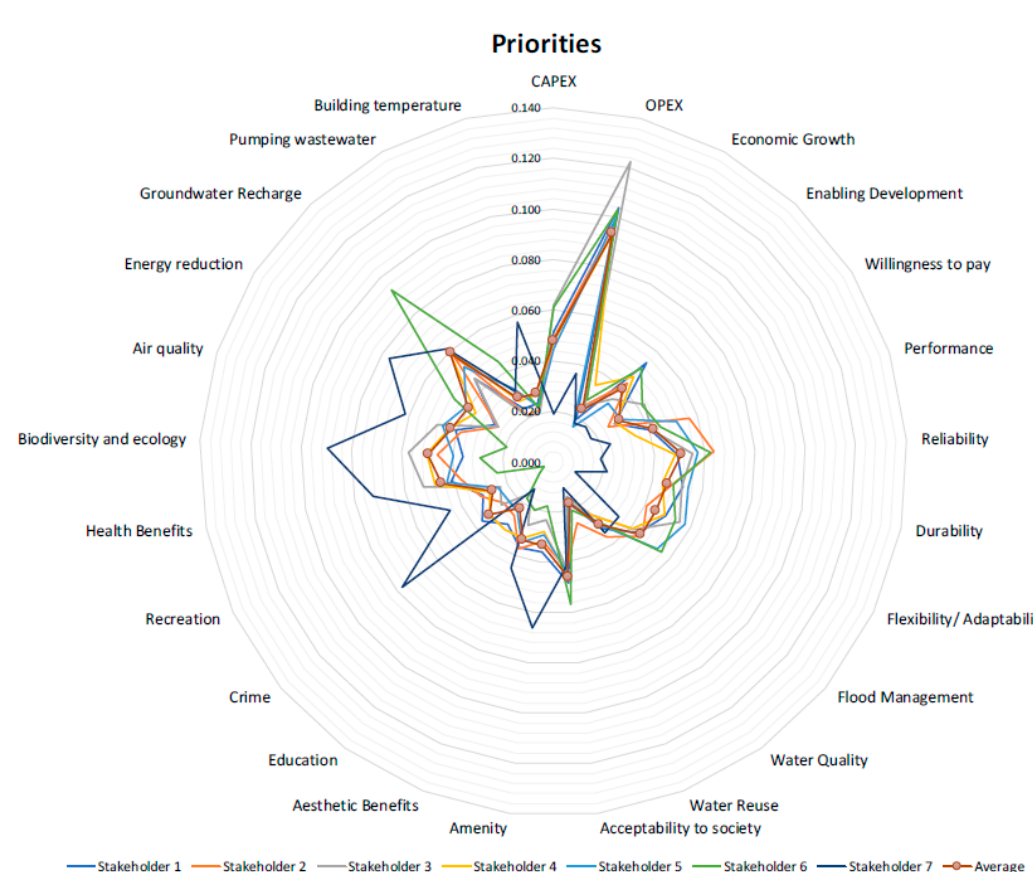
Figure 6. Priorities of each stakeholder and the average value using ANP for the UK SuDS case study. ANP, Analytic Network Process; CAPEX, CAPital Expenditure; OPEX, OPerating EXpense.